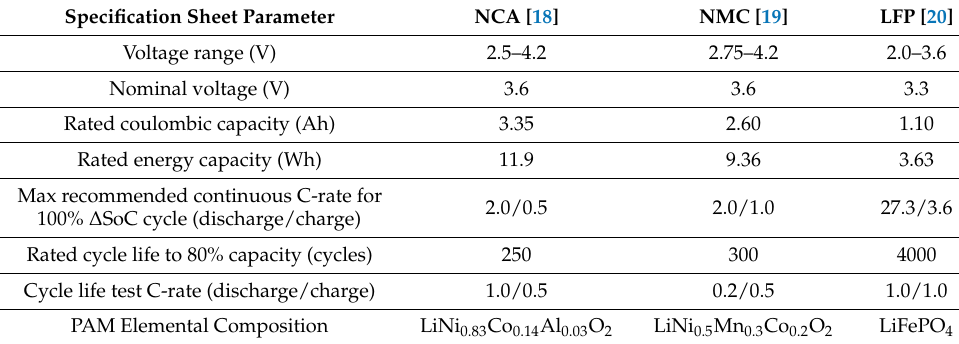
Table 1. Single 18–65 cylindrical cell manufacturer datasheet specifications.